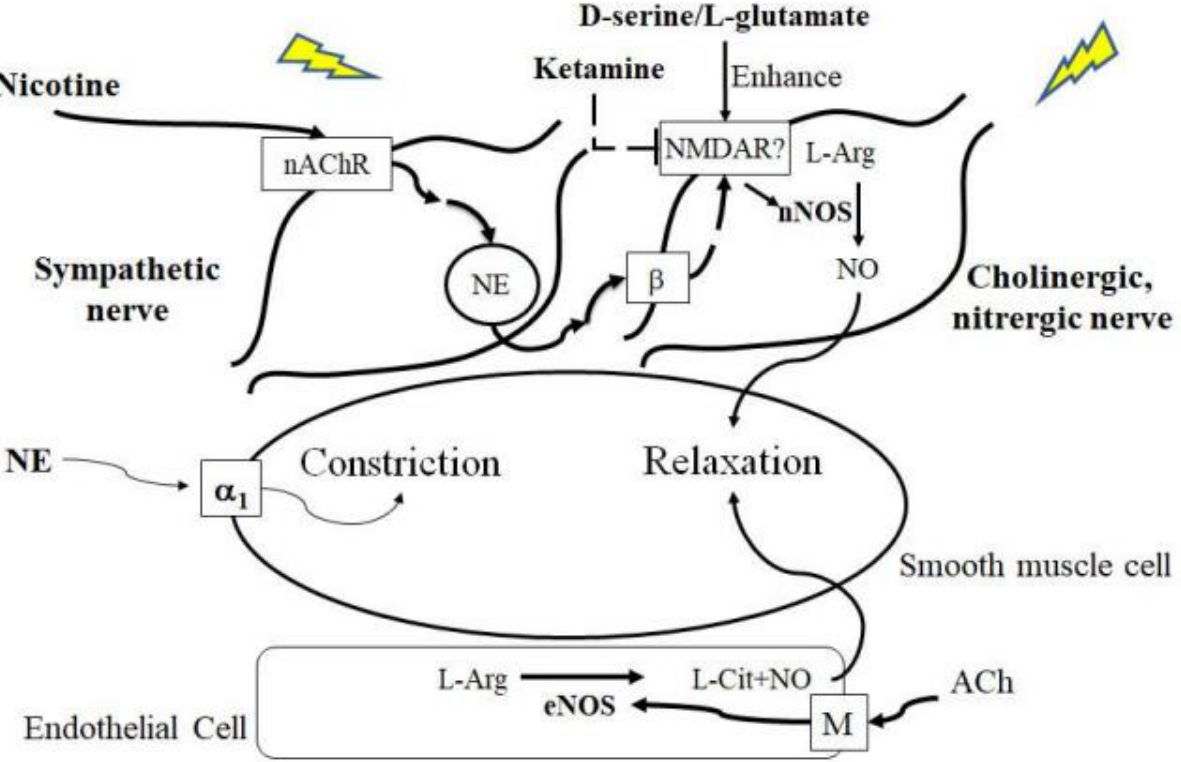
Figure 6. Mechanisms of ketamine on nicotine-induced neurogenic relaxation and sympathetic–parasympathetic nerve interaction in the corpus cavernosum.